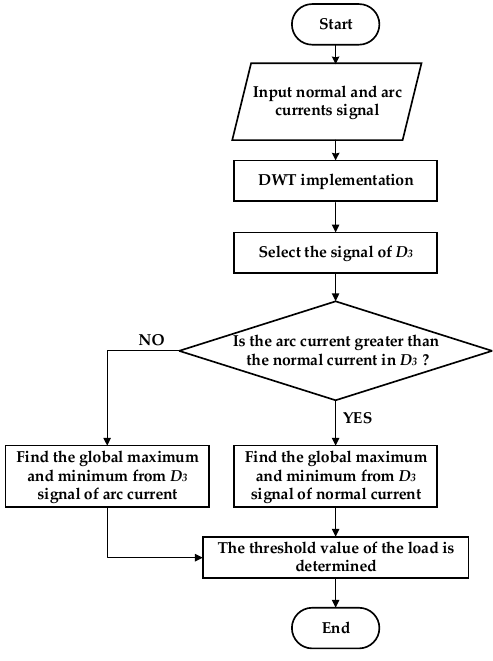
Figure 10. Setting of the threshold for the DWT.